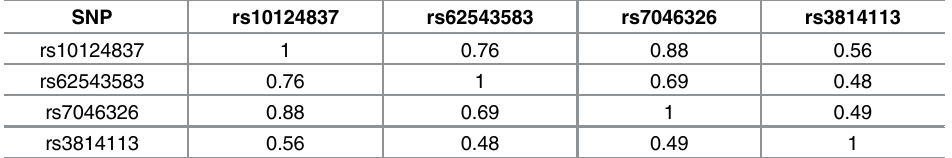
Table 2. Pairwise correlations (r 2 ) between selected SNPs. SNPs correspond to: rs10124837, the stron- gest associated in BRCA1 ; rs62543583, the strongest associated in BRCA2 mutation carriers; rs7046326, the strongest associated in BRCA1/2 meta-analysis; rs3814113, was the strongest associated variant in the initial GWAS